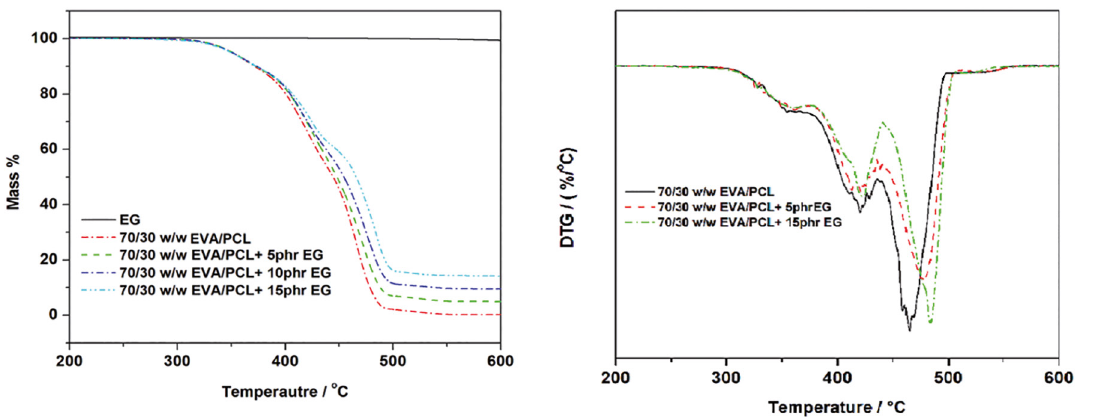
Figure 7: TGA and DTG curves of EVA/PCL blend and EVA/PCL blend with different content of EG